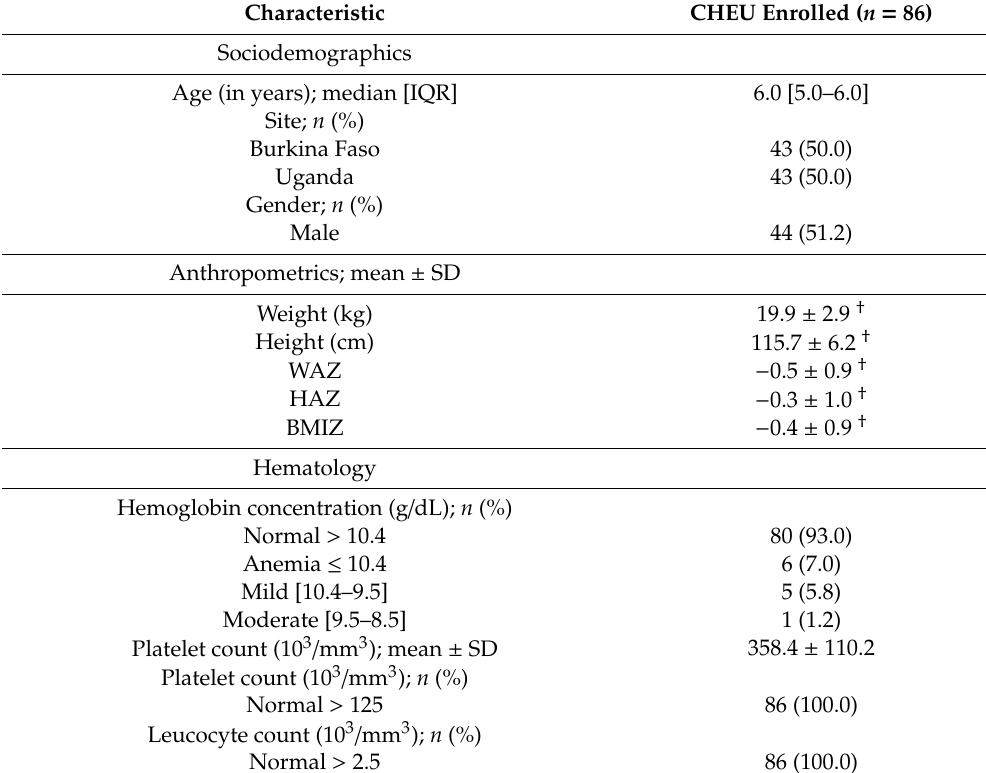
Table 1. Characteristics of children who are human immunodeficiency virus (HIV)-exposed but uninfected (CHEU) enrolled in the